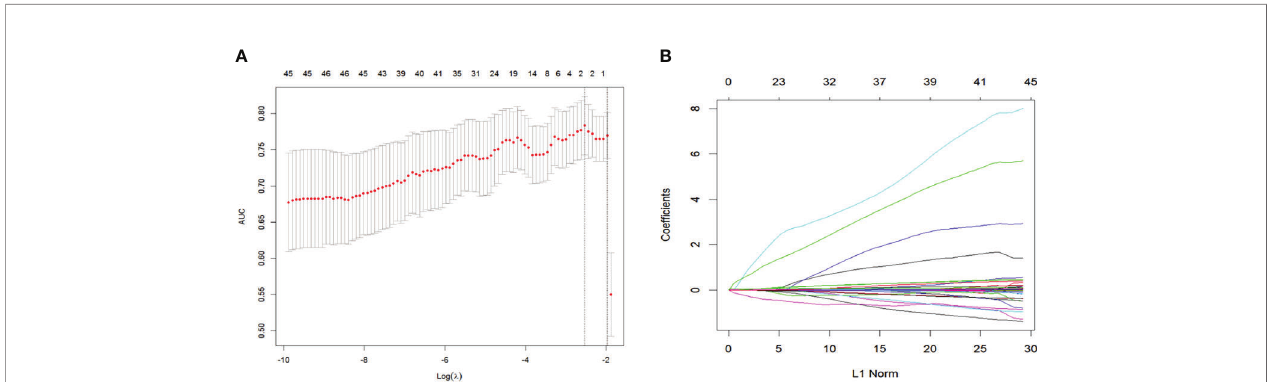
FIGURE 1 | Texture feature selection using the LASSO binary logistic regression model. (A) By selecting a 10-fold cross-validation in the LASSO model with minimum standards. The binomial deviance was plotted versus log ( l ). Dotted vertical lines were drawn at the optimal l values based on the minimum criteria and 1 standard error of the minimum standards and the optimal l was 0.069. (B) The LASSO logistic regression algorithm was used to screen out 2 features with non- zero coef fi cients out of 46 features. LASSO, least absolute shrinkage and selection